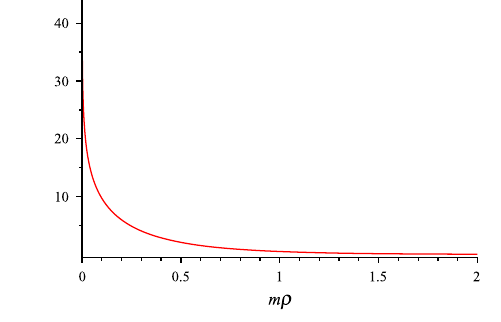
Fig. 3 Graphic for the function F ( m